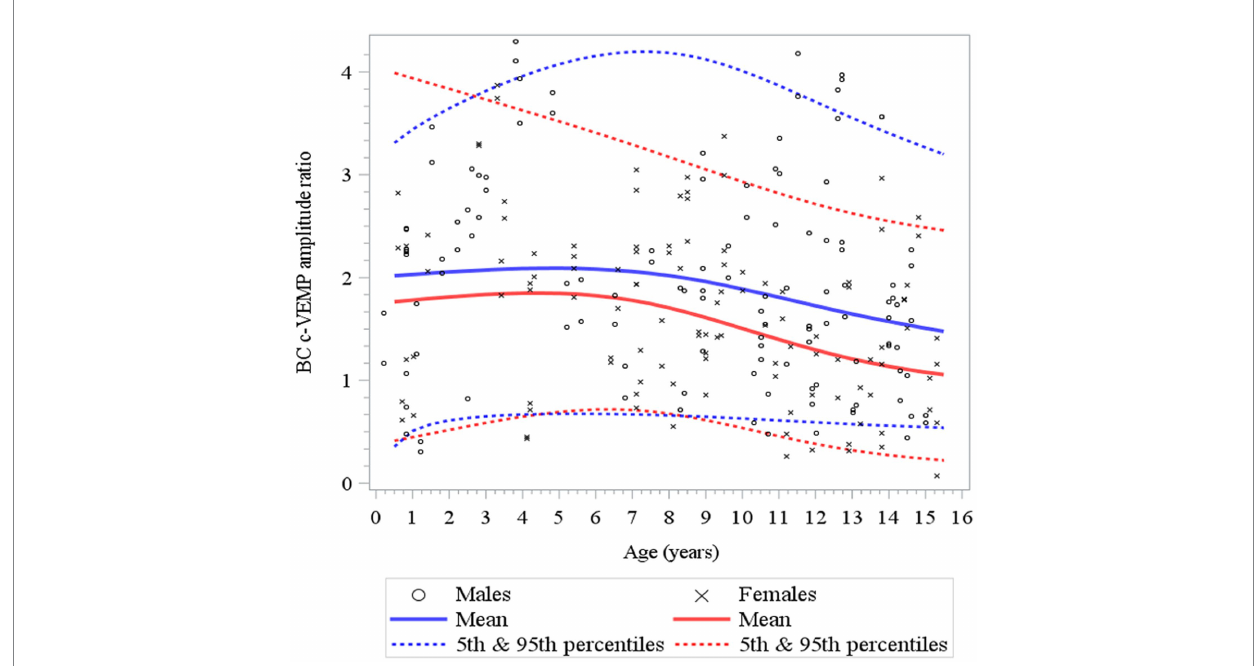
FIGURE 8 Changes in c-VEMP amplitude ratio for BC (bone conduction) stimulation as a function of age and gender for children (6 months to 15 years of age) (26). For BC the model shows that data are relatively stable function of age with a small increase during the first 4 to 5 years followed by a slow decline. Note also that the mean amplitude ratio is higher in males than in